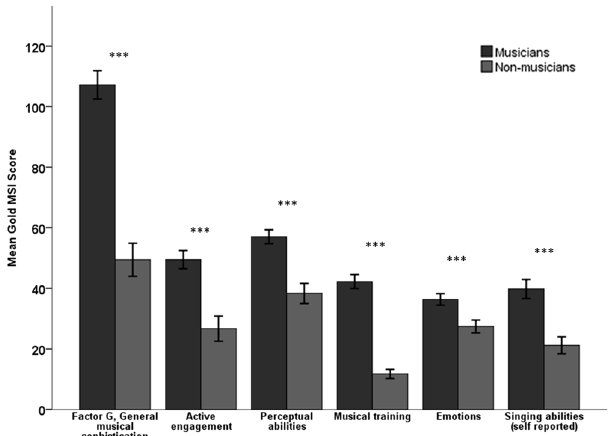
Figure 5. Scores on the six subscales of Goldsmiths Musical Sophistication Index, (Gold MSI), v.1.0. Independent t-tests showed statistically significant differences between the groups for all subscales, *** p < 0.001. Error bars indicate 95% confidence